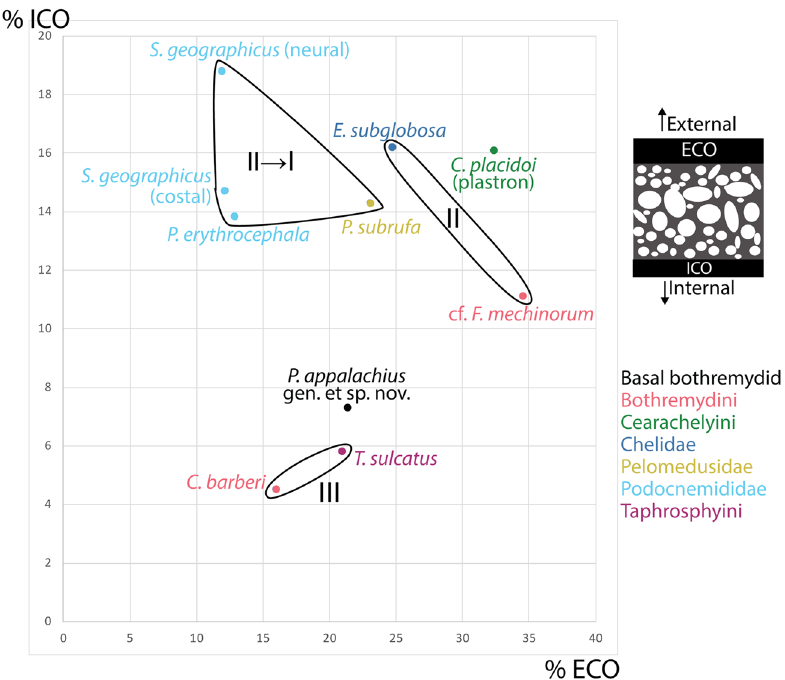
Figure 8. Results of histological comparison of fossil and extant pleurodiran taxa, comparing relative thicknesses of internal ( ICO ) and external cortices ( ECO ) to total shell thickness. Roman numerals indicate ecological adaptation categories of Scheyer 45 : I terrestrial, II semiaquatic to mainly aquatic, and III fully aquatic. Measurements taken from Scheyer and Sánchez-Villagra 72 . Assignment to categories from Scheyer 45 , Appendix 3. Schematic at upper right shows generalized cross section of diploë structure in turtle